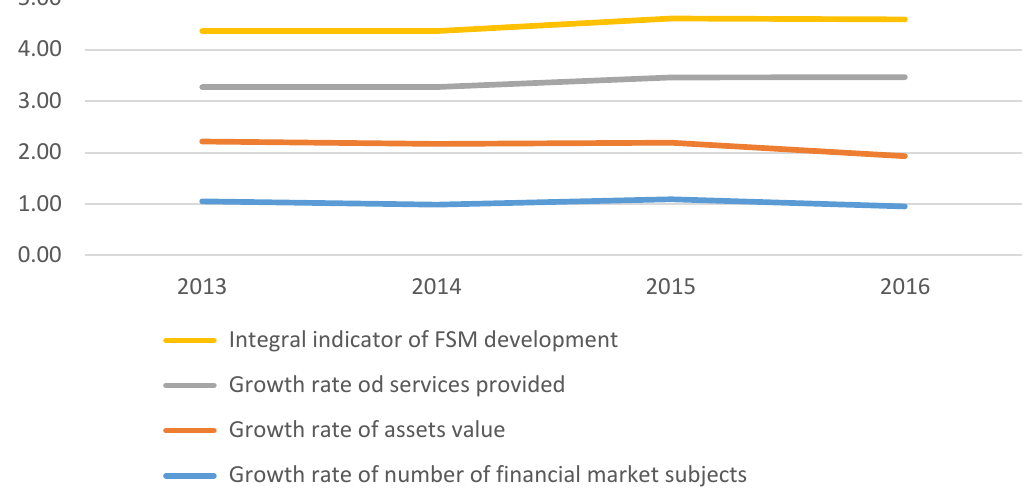
Figure 2. Dynamics of development indicators of the Ukrainian financial market for 2013–2016